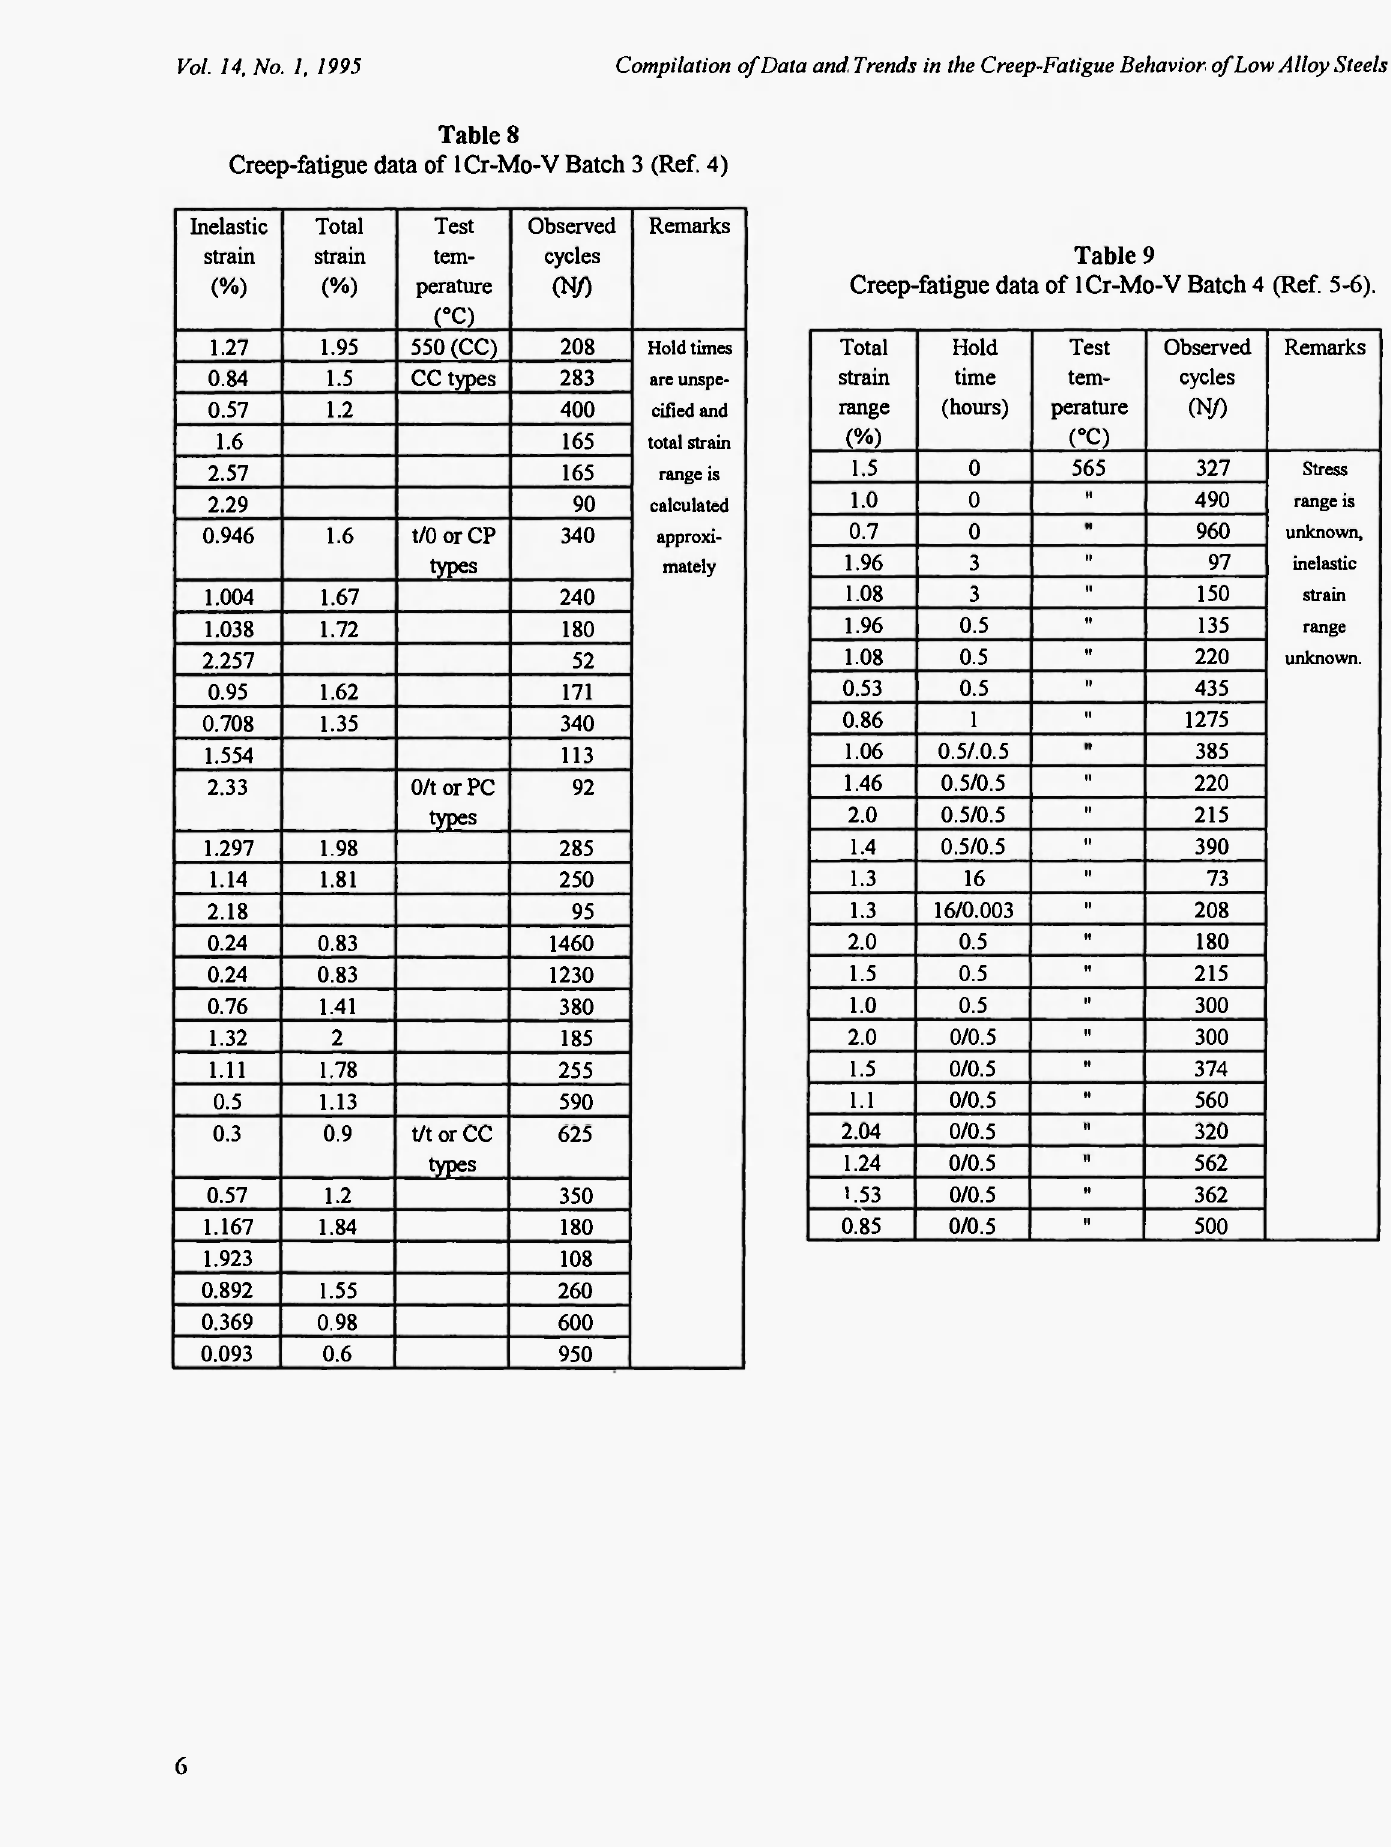
Creep-fatigue data of lCr-Mo-V Batch 4 (Ref.